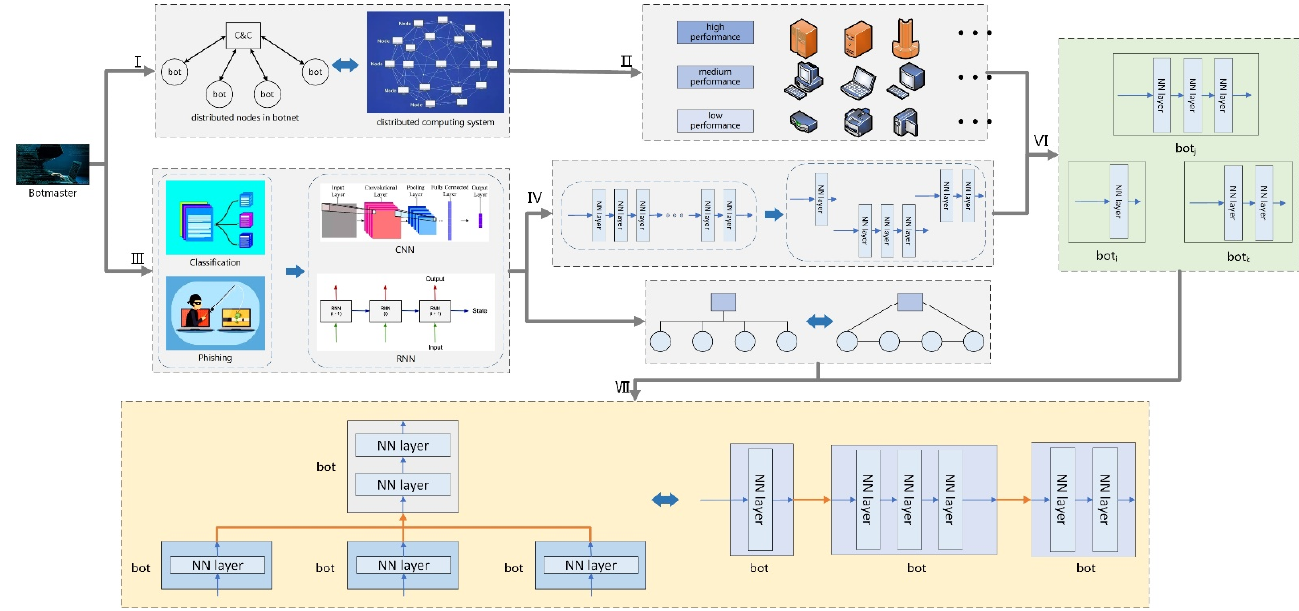
Figure 3. AIBot operational framework.